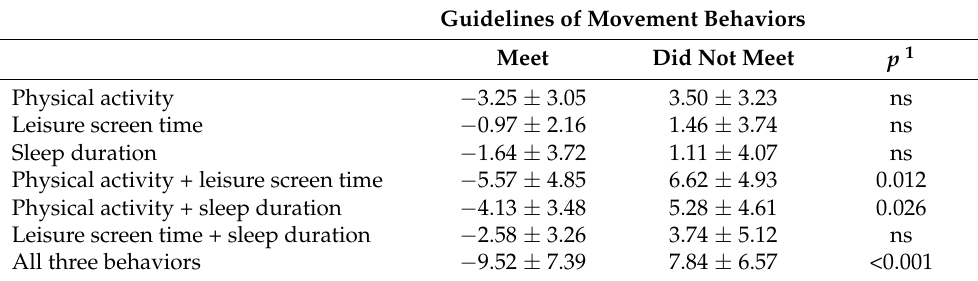
Table 3. Comparisons between the continuous cardiometabolic health scores of adolescents who met and who did not meet the guidelines of movement